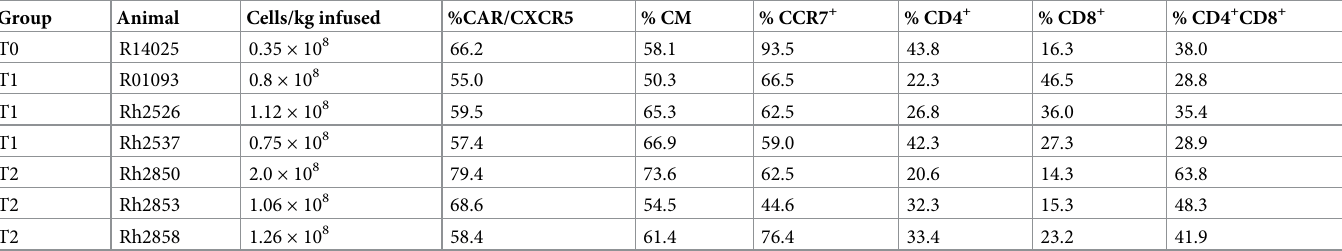
Table 2. Cell infusions. Group